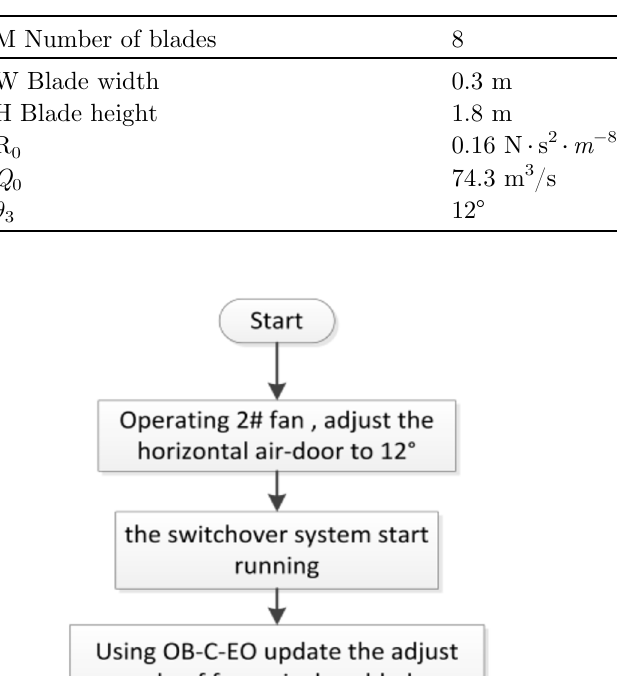
Table 6. Simulation parameter settings.